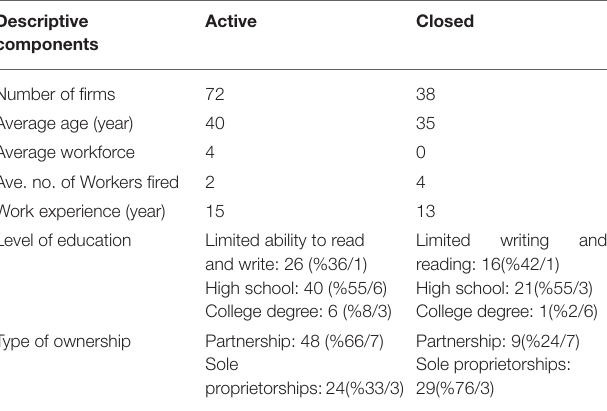
closed MSEs. Descriptive